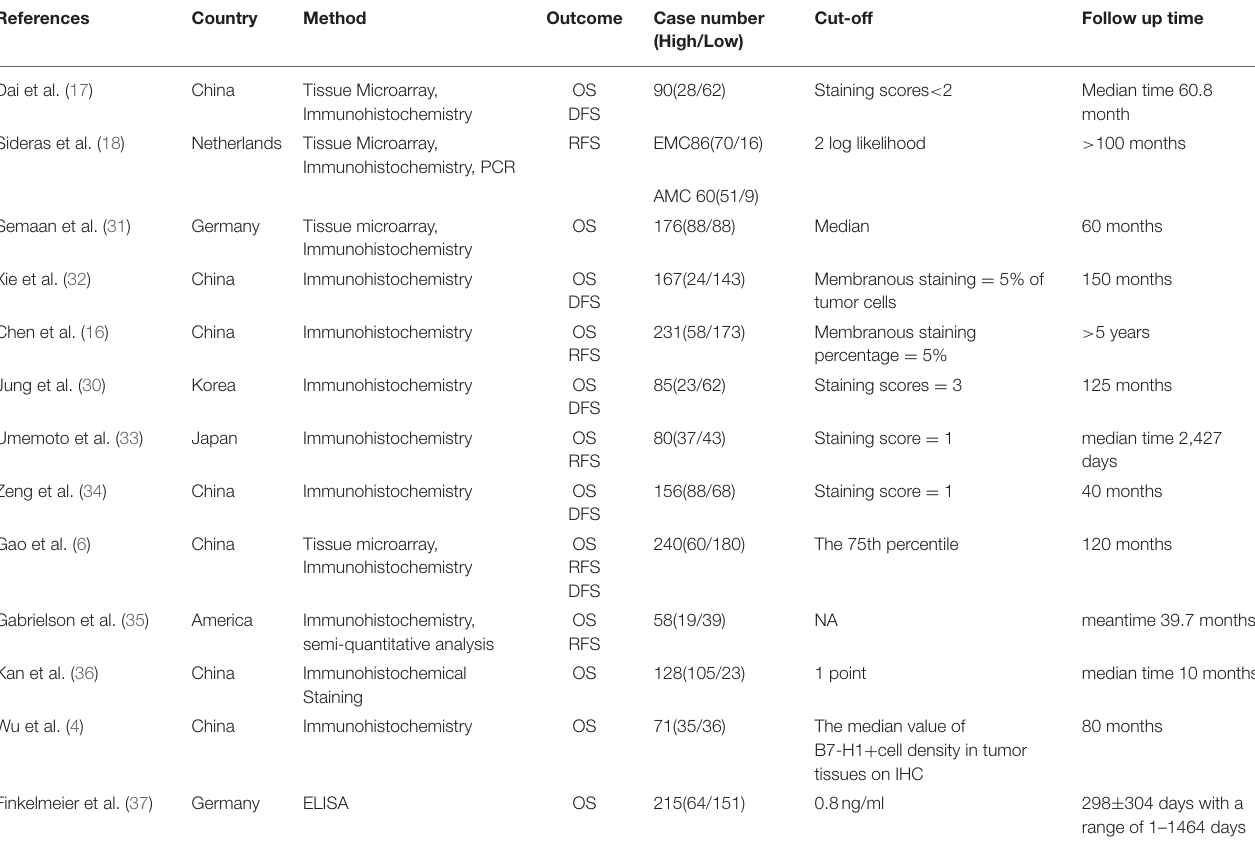
TABLE 1 | The characteristics of studies included in the